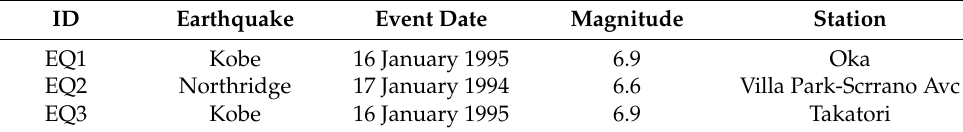
Table 1. Seismic